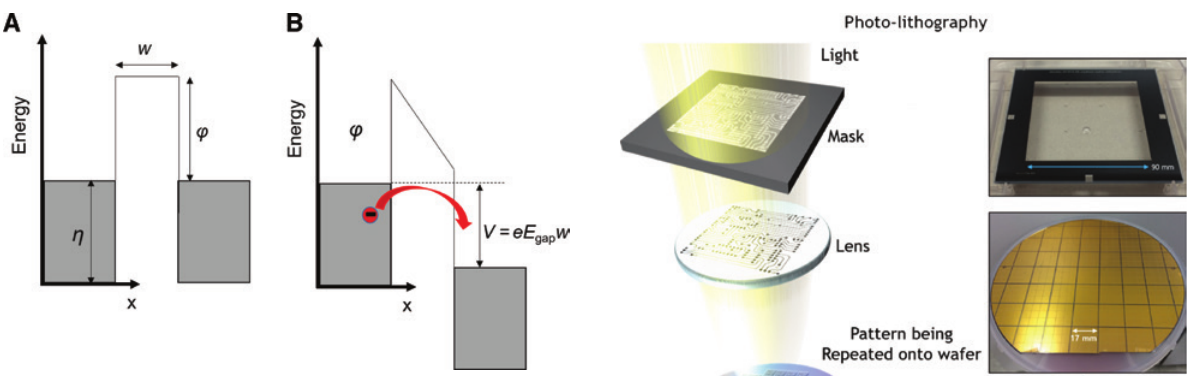
Figure 15: Electron tunneling through a nanogap. Tunnel junction (A) without and (B) with strong electric field in the gap, E . Here, η is the Fermi level and ϕ is the barrier height. gap